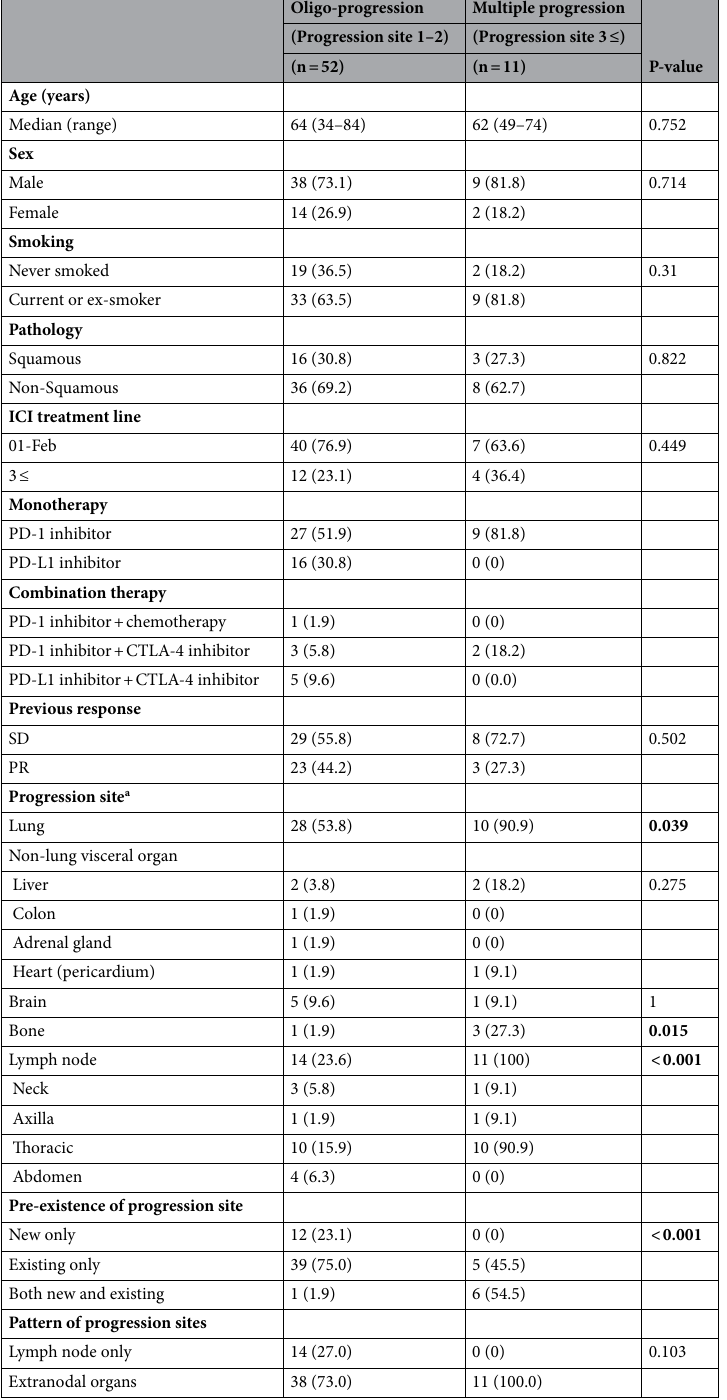
Table 3. Baseline characteristics based on oligo-progression. Bold values denote statistical significance at the p < 0.05 level PR partial response, SD stable disease, PD-1 programmed death 1, PD-L1 programmed death group based on the site of progression 13